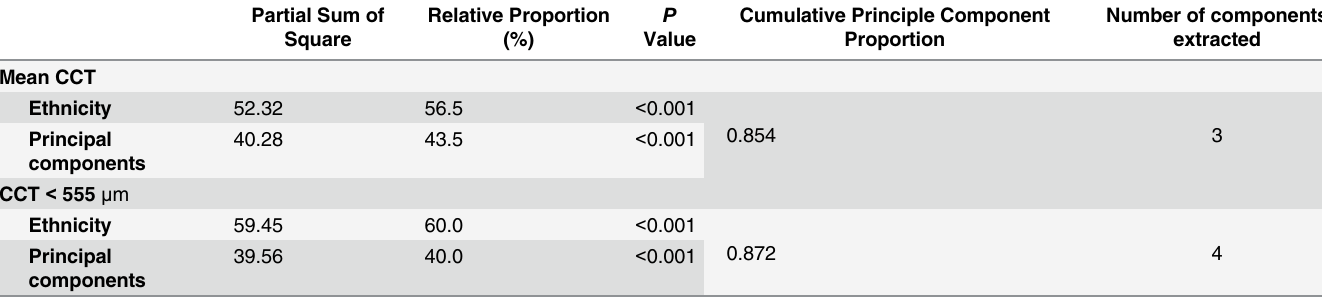
Table 3. Principle component analysis one the association between ethnicity and other significant associated factors.